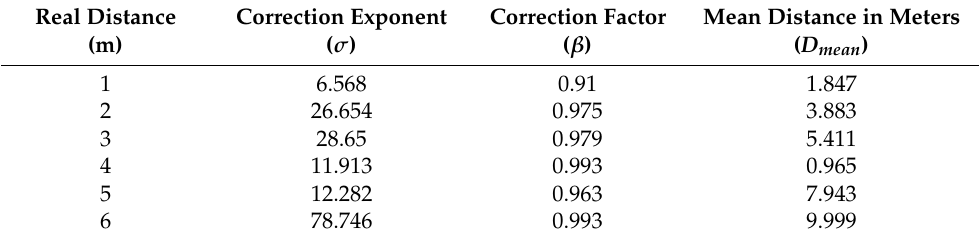
Table 3. The output factors of the RSSI distance prediction and correction model from one beacon at the